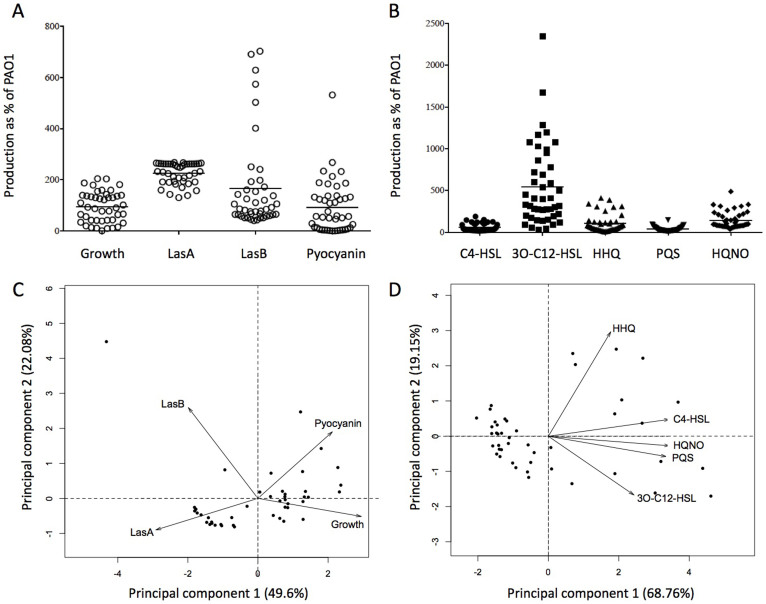
Phenotypic diversity of P. aeruginosa populations.We measured growth, exoproducts and QS signal molecules of individual isolates and expressed these as a percentage of the values obtained for a PAO1 wildtype. Each data point represents the mean of triplicate assays for an individual isolate. (A) Phenotypic assays for growth and exoproduct production show that isolates display large variation between individuals when compared with the PAO1 reference strain. (B) QS Signal molecule measurements show that variation occurs between isolates when compared to the PAO1 reference strain. Panels (C) and (D) show the results of PCA on phenotypic and QS signal data respectively. PCA reduces multiple variables (four phenotypic traits or five QS molecules) to two dimensions, allowing us to plot multivariate data on simple x,y coordinates. The arrows are vectors that show how the original variables relate to the new x and y axes. The PCA plots show that QS signals are linked and that tradeoffs exist between other phenotypes measured.